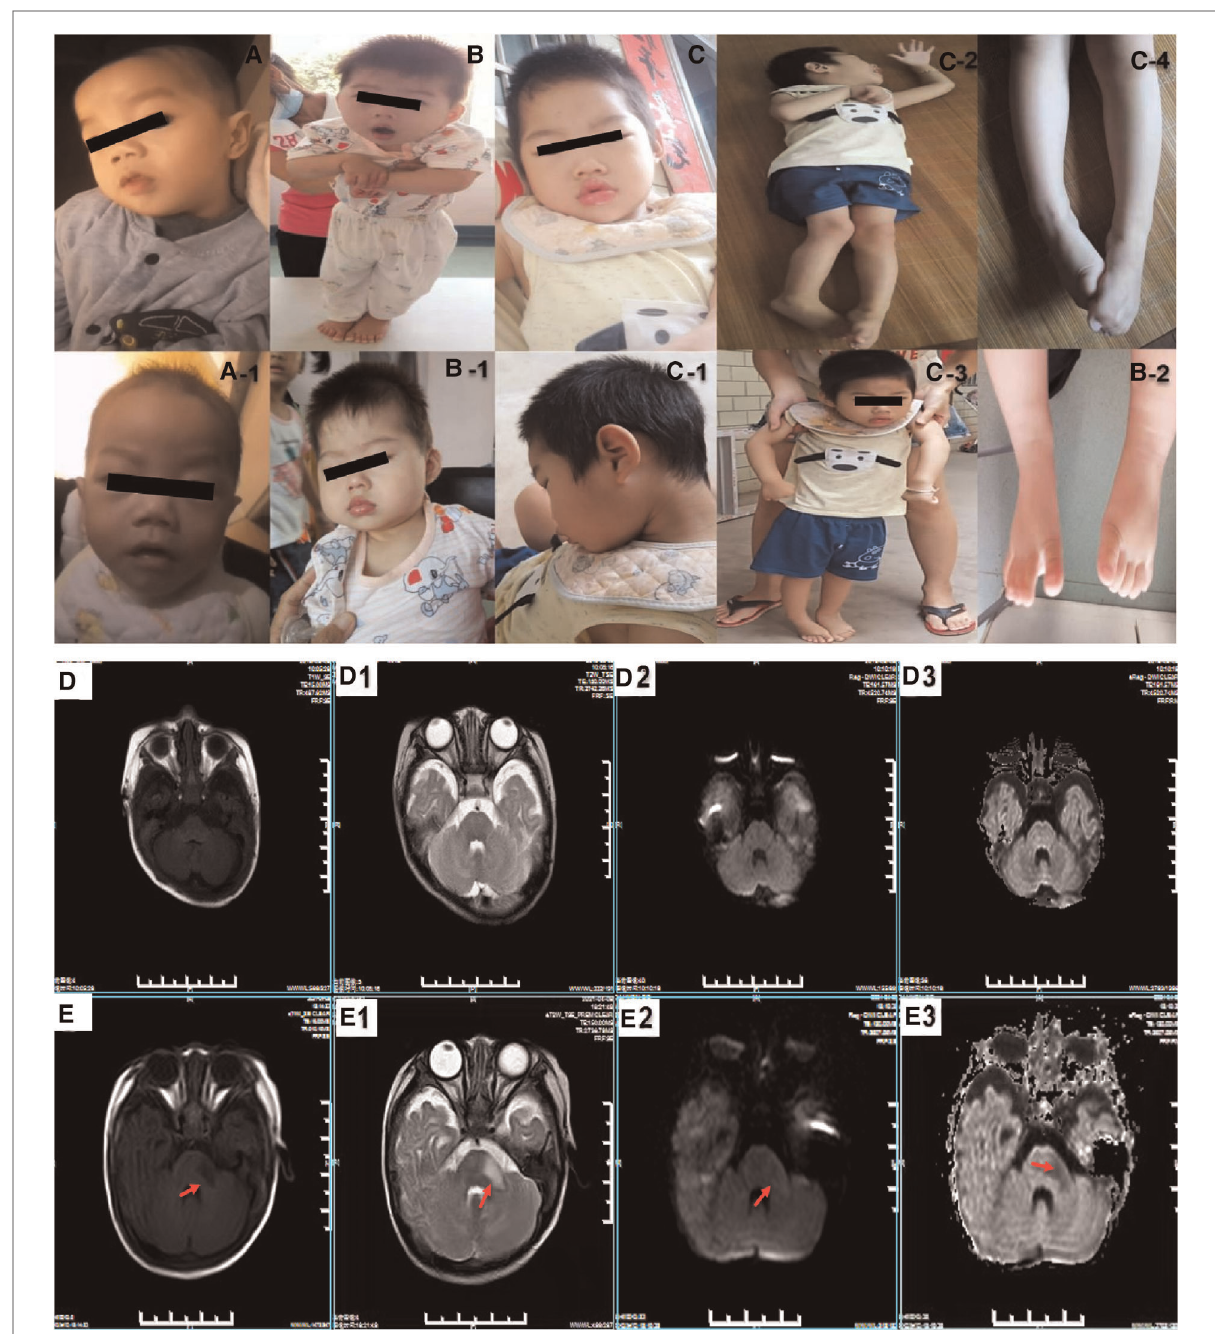
FIGURE 1 The clinical features of the probands with Allan-Herndon-Dudley Syndrome. ( A , A-1 ) show the phenotypic characteristics of patient 1: fi xed facial expression and neck muscle weakness. ( B – B-2 ) show the phenotypic characteristics of patient 2: fi xed facial expression and muscle weakness. ( C – C- 4 ) show the facial features and muscle weakness and special posture of patient 2 ’ s elder brother. ( D – D3 ) show the cranial MRIs of patient 1 (normal). ( E – E3 ) are patient 2 cranial MRIs. ( E,E – E3 ) represent T1WI, T2WI, a high b-value DWI and ADC images, respectively. The results reveal a patchy long T1 and a long T2 signal shadow in the leftmid-cerebellar peduncle, with a slightly highsignal onhighb-value DWI and a slightly low signal